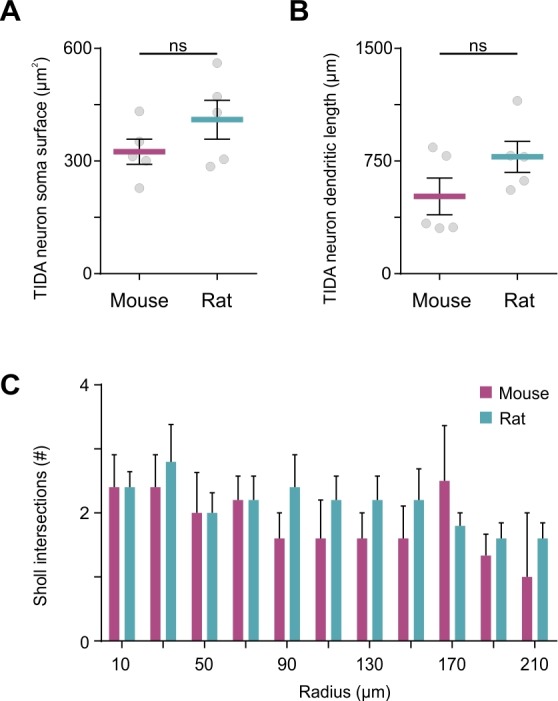
Comparison of TIDA neuron cytoarchitecture between rat and mouse.(A–C) Cell soma size (A), total dendrite length (B) and dendrite branching distribution (C) in TIDA neuron is statistically similar between the two species (n = 5 cells per group).